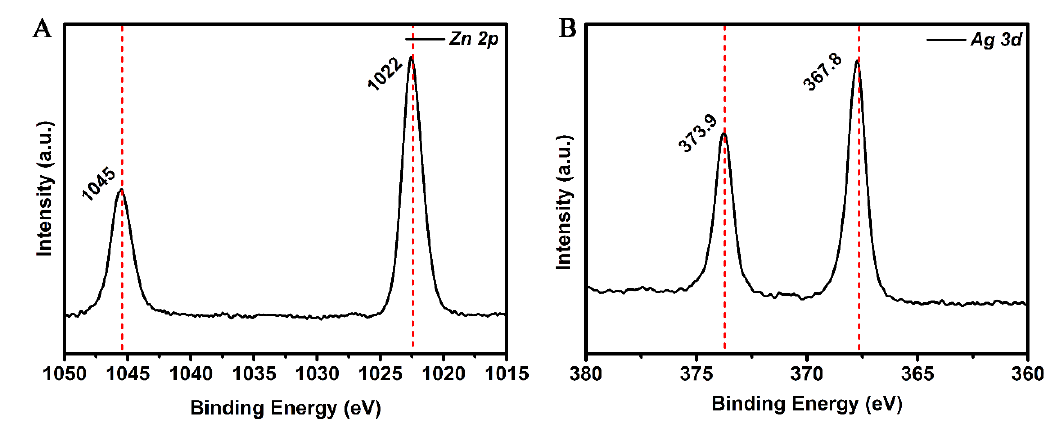
Figure 3. ( A )XPS spectra of Zn 2p; ( B ) Ag 3d.